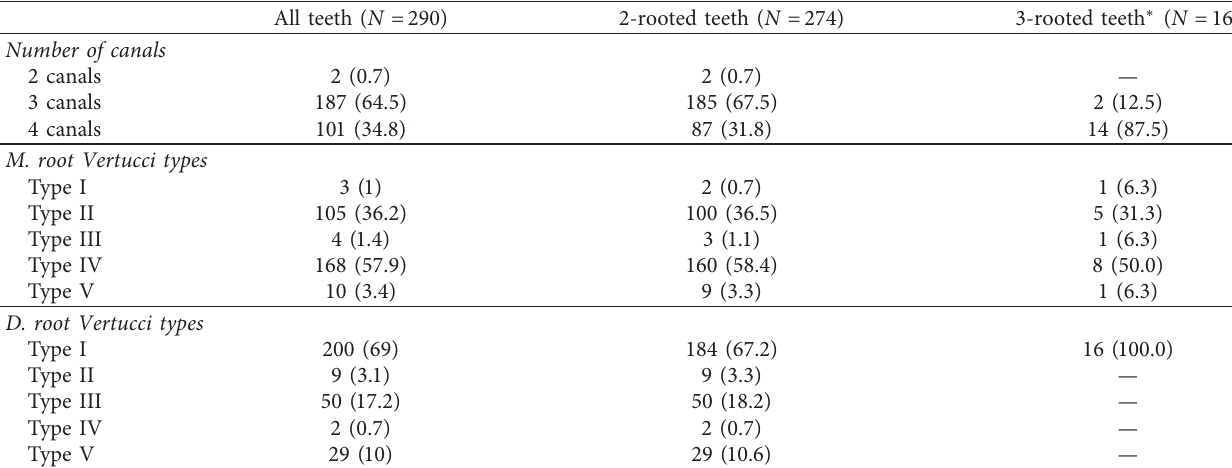
Table 1: Frequency of number of roots, number of canals, and Vertucci type among mandibular 1 st molars N (%).